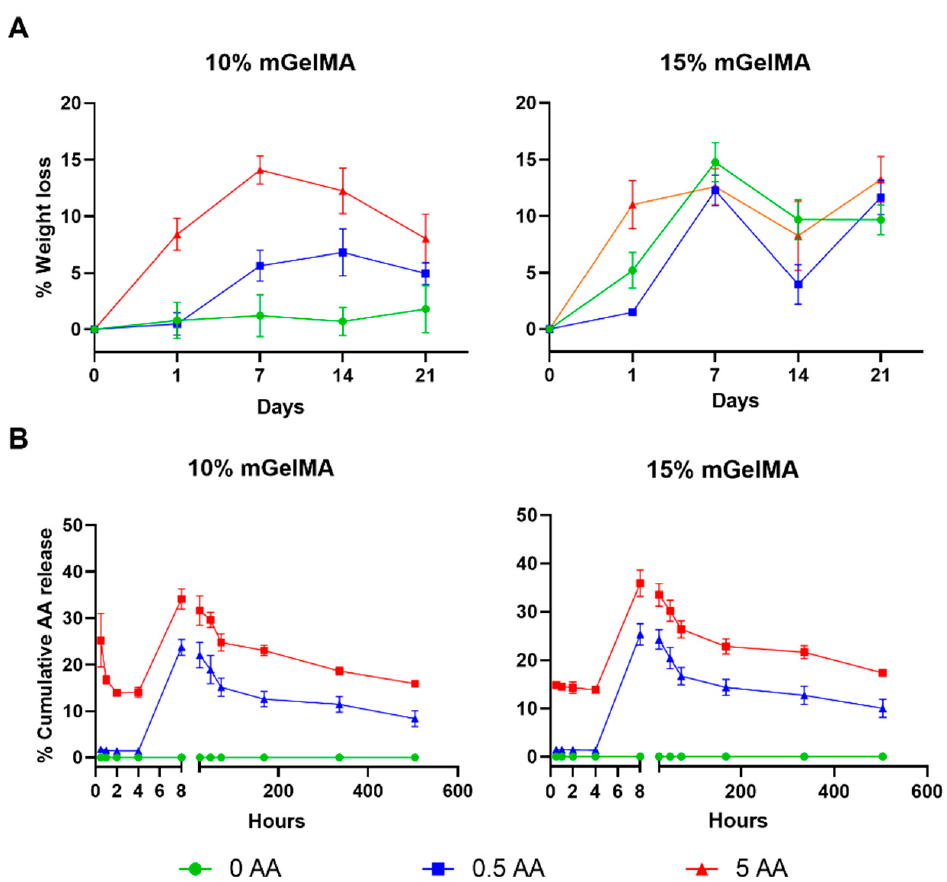
Figure 6. Degradation of mGelMA hydrogels in PBS and ascorbic acid (AA) release. ( A ) Degradation profile of mGelMA hydrogels with different AA concentrations (0, 0.5, or 5 mg/mL) in 21 days in PBS at 37 °C. ( B ) Ascorbic acid cumulative release profile during 21 days at 37 °C. Values are shown as mean ± SD ( n = 6).